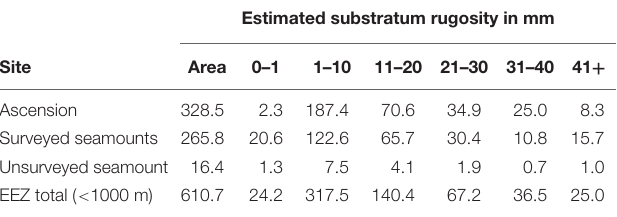
TABLE 4 | Areas in km 2 less than 1000 m deep around Ascension by each rugosity